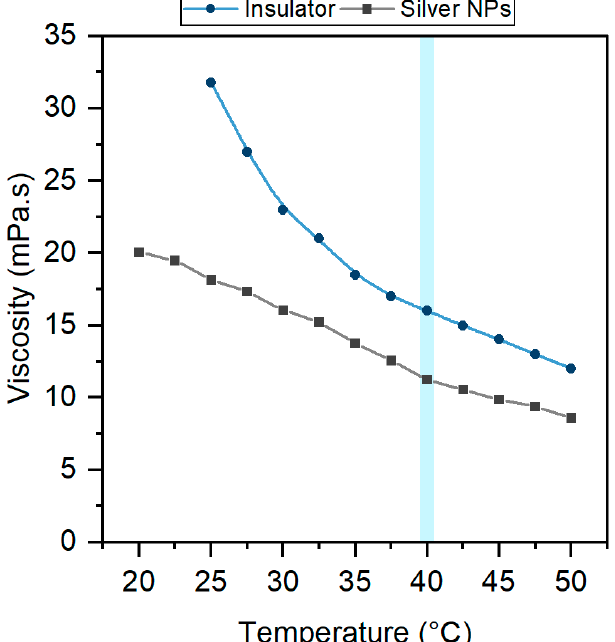
Figure A1. Plot of the viscosity variation of both the functional silver nanoparticle and the insulator inks as a function of temperature. The printable region chosen was at 40 °C, highlighted in light blue on the plot.